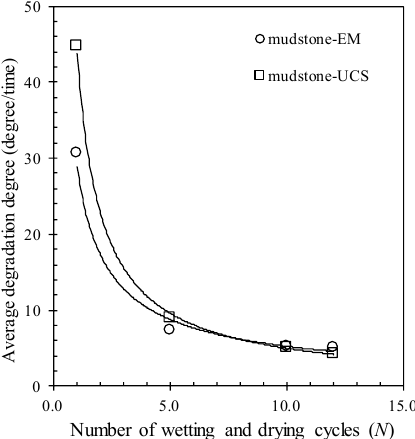
Figure 13. Average degradation degree of UCS and EM of mudstone after wetting-drying cycles. Processes 2018 , 6 , x FOR PEER REVIEW